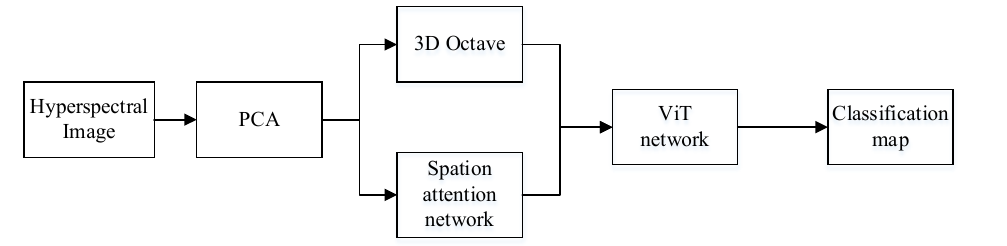
Figure 2. Flow of framework for